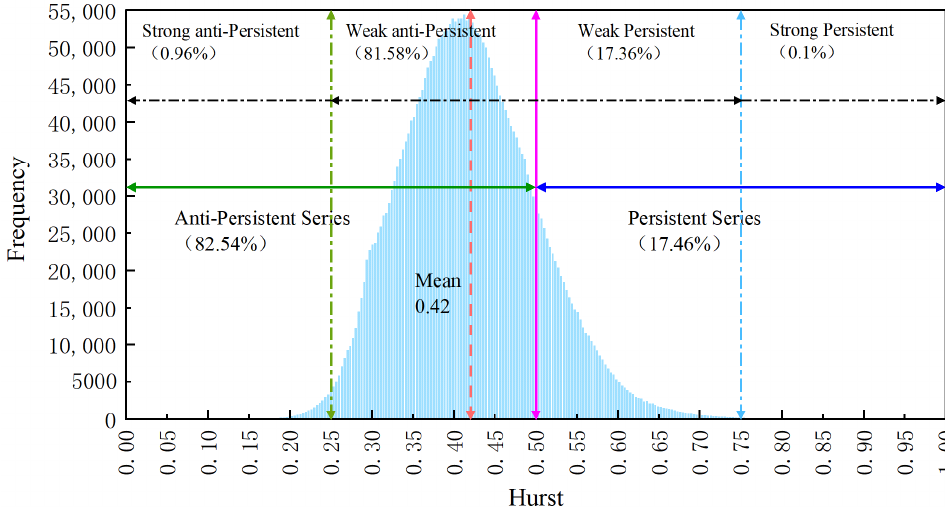
Figure 11. Normal distribution chart of the NEP Hurst index. According to the definition of the Hurst index; we take 0.5 as the dividing line. Parts larger than 0.5 are called ‘Persistent Series’, and parts smaller than 0.5 are called ‘Anti-Persistent Series’; at the same time, we have further classified them. In the ‘Persistent Series’, 0.5~0.75 parts are defined as ‘Weak Persistent’, and 0.75~1.00 parts are defined as ‘Strong Persistent’; In the ‘Anti-Persistent Series’, the 0.25~0.5 parts are defined as ‘Weak anti-Persistent’, and the 0.00~0.25 parts are defined as ‘Strong